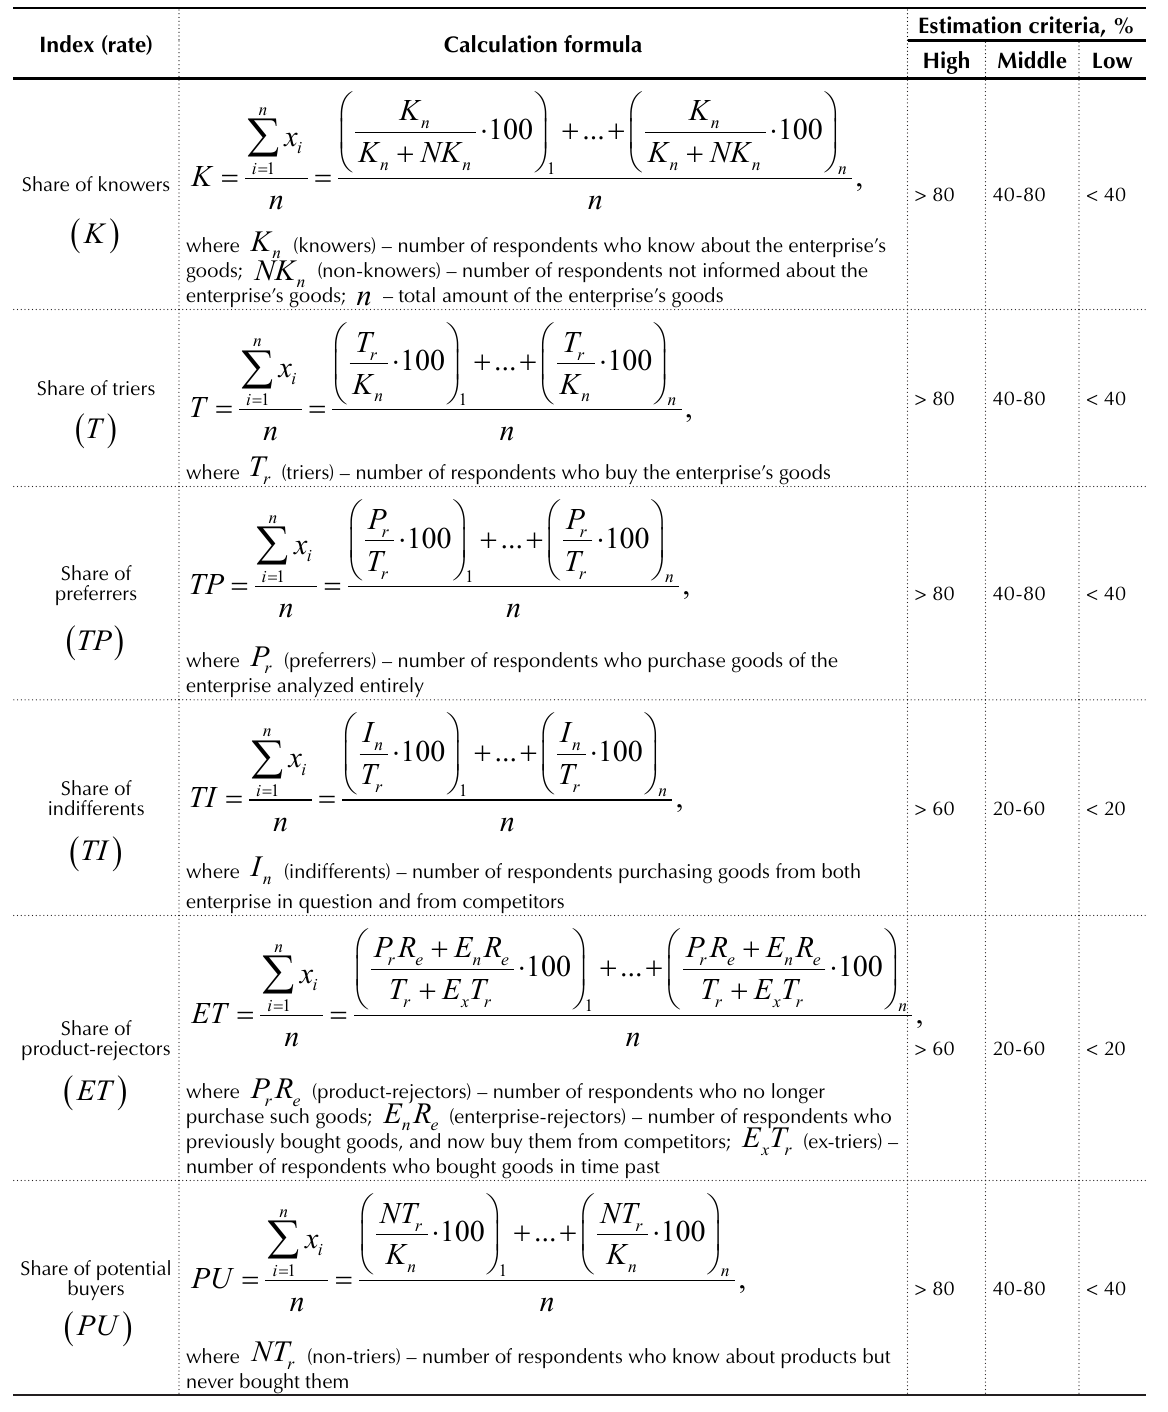
Table 2. Analytical support for implementation of enterprise loyalty programs Index (rate) Calculation formula